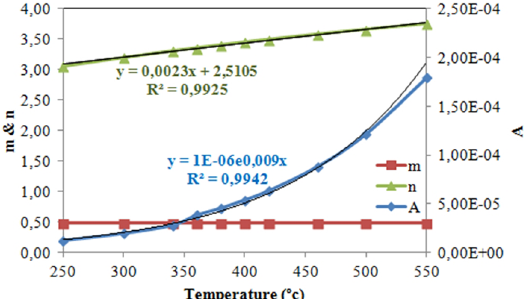
Figure 1 are the Norton-Bailey constants (equations 9 to 11) with temperature.